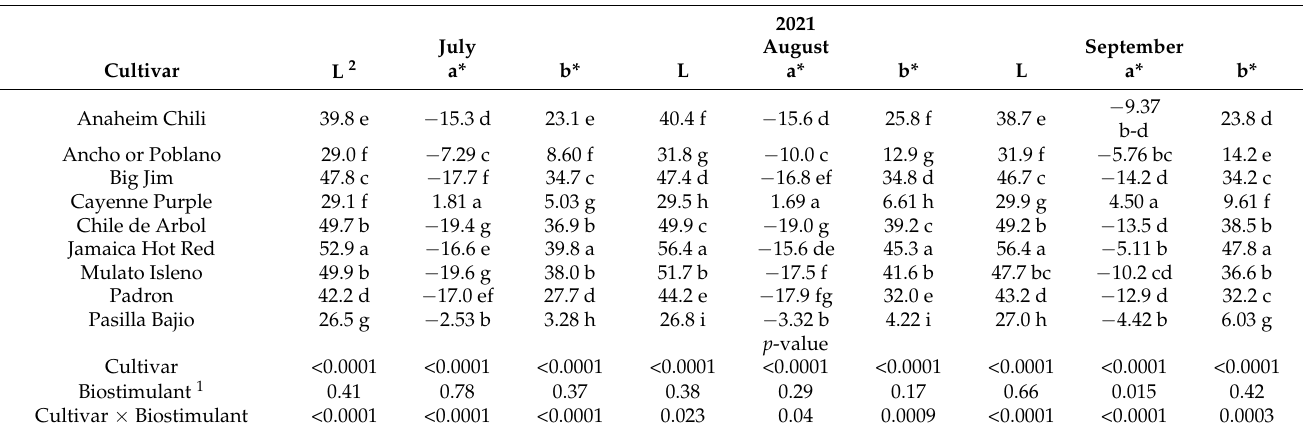
Table 9. Fruit color measurements of nine heirloom chile pepper cultivars treated with three types of biostimulants grown in a container production system in Starkville, Mississippi, in